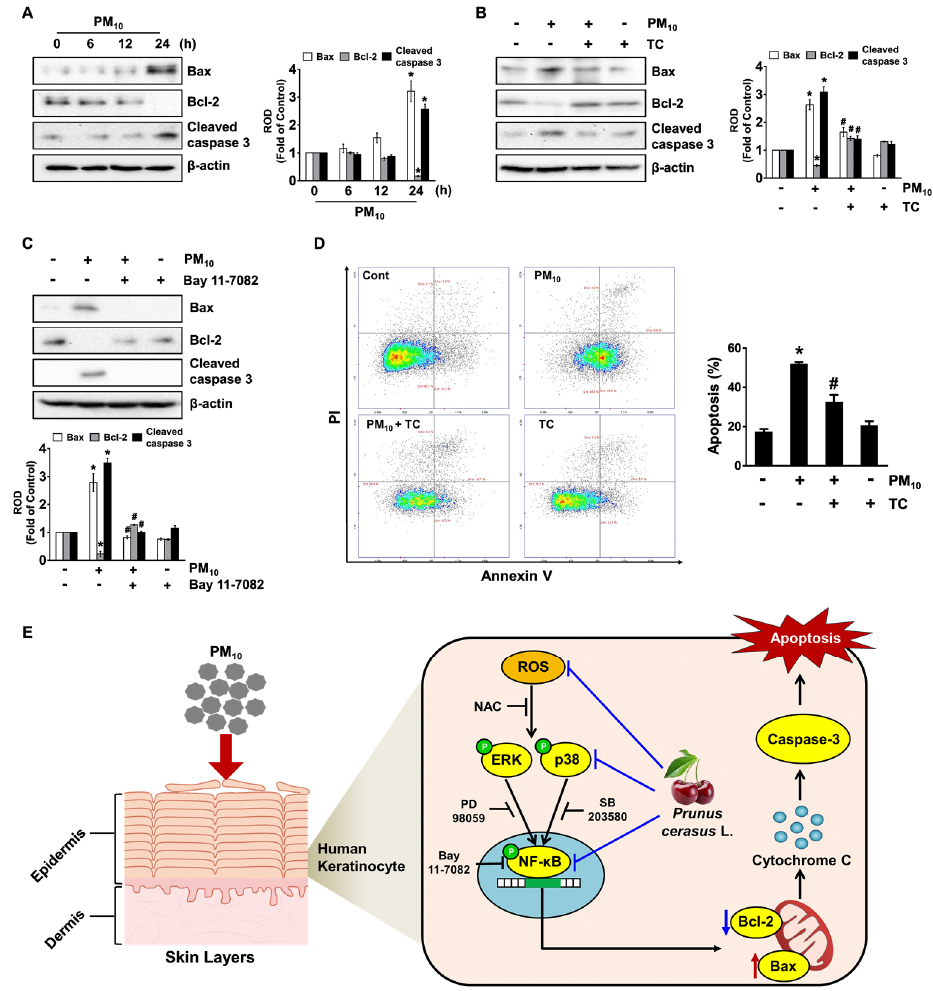
Figure 5. The pharmacological effect of tart cherry on keratinocyte apoptosis induced by PM 10 . ( A ) Time-dependent response of PM 10 (100 µ g/mL) on the expression of Bax, Bcl-2, and cleaved caspase-3 in HaCaT cells as determined by Western blot. ( B ) The effect of tart cherry (TC, 200 µ g/mL) on the expression of apoptosis-related proteins is shown. ( C ) Cells pretreated with Bay 11-7082 (10 µ M) as an inhibitor for NF- κ B were incubated with PM 10 for 24 h. ( D ) Cells were incubated with tart cherry and PM 10 for 24 h. The proportion of apoptotic cells stained by Annexin V was analyzed using the NucleoCounter ® advanced image cytometer. ( E ) The sequences of putative signaling pathways are summarized. ( A – D ) Data are represented as the means ± S.E. n = 3. * p ≤ 0.01 vs. control. # p ≤ 0.01 vs. PM 10 alone. ROD, relative optical